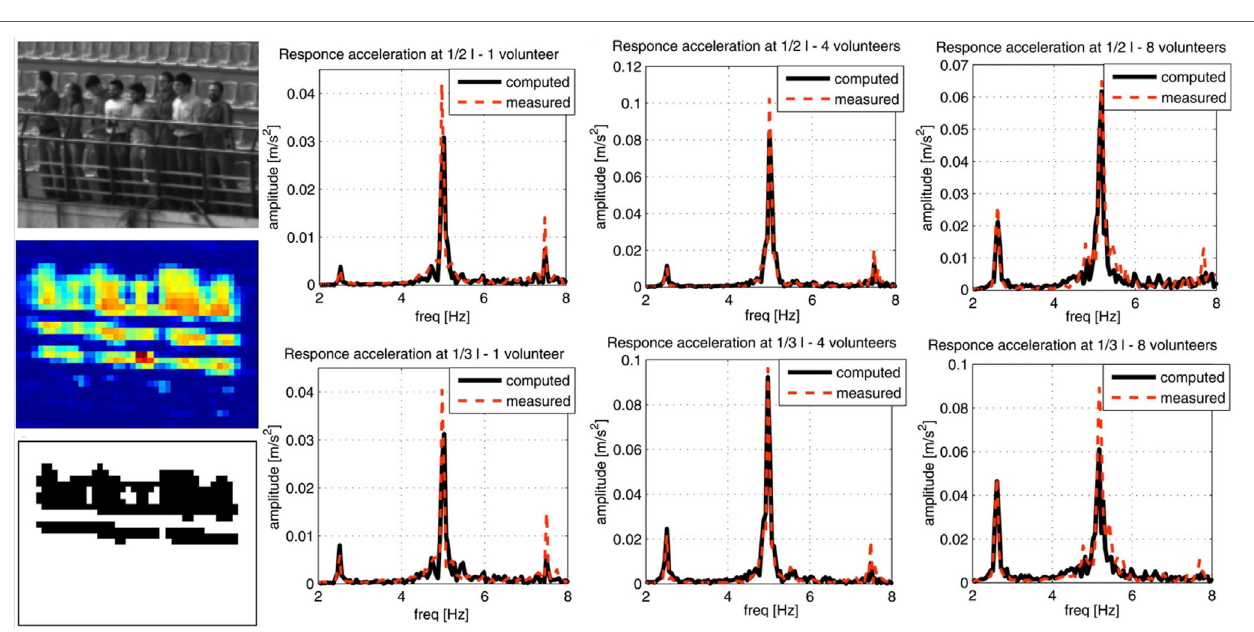
FiGURe 6 | Comparison between measured and estimated forces for both jumping and bobbing tests at 2.5 Hz; results in both time and frequency domain. Reprinted from (Mazzoleni and Zappa, 2012) with permission from Elsevier. (A) Locations of accelerometers on human body; (B) Mass distribution over different body parts.